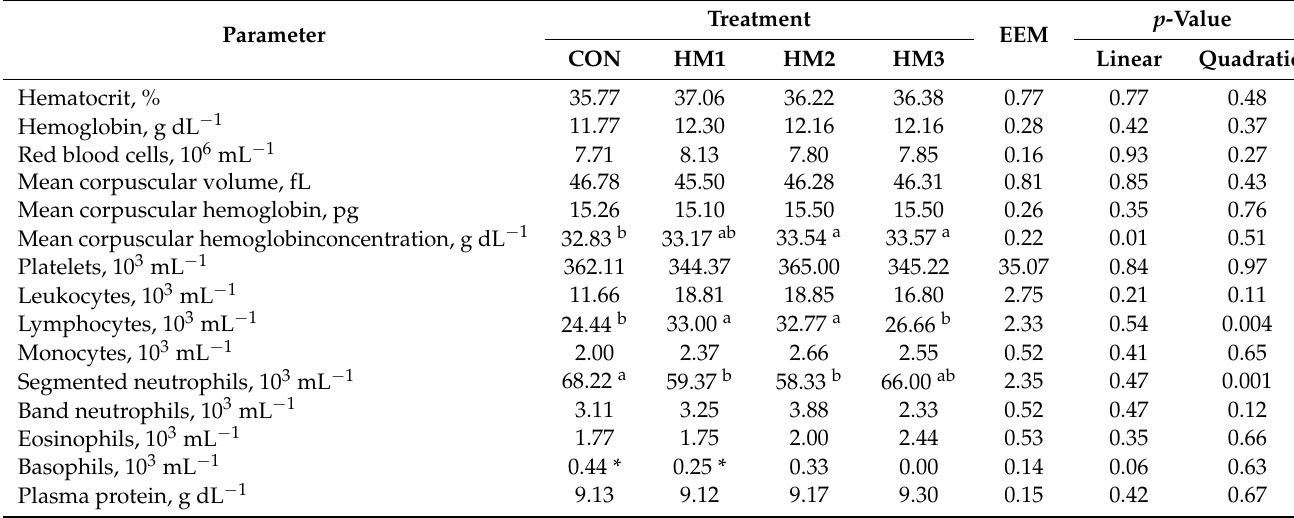
Table 5. Hematological profile of lambs supplemented with a polyherbal mixture 1 during the final fattening